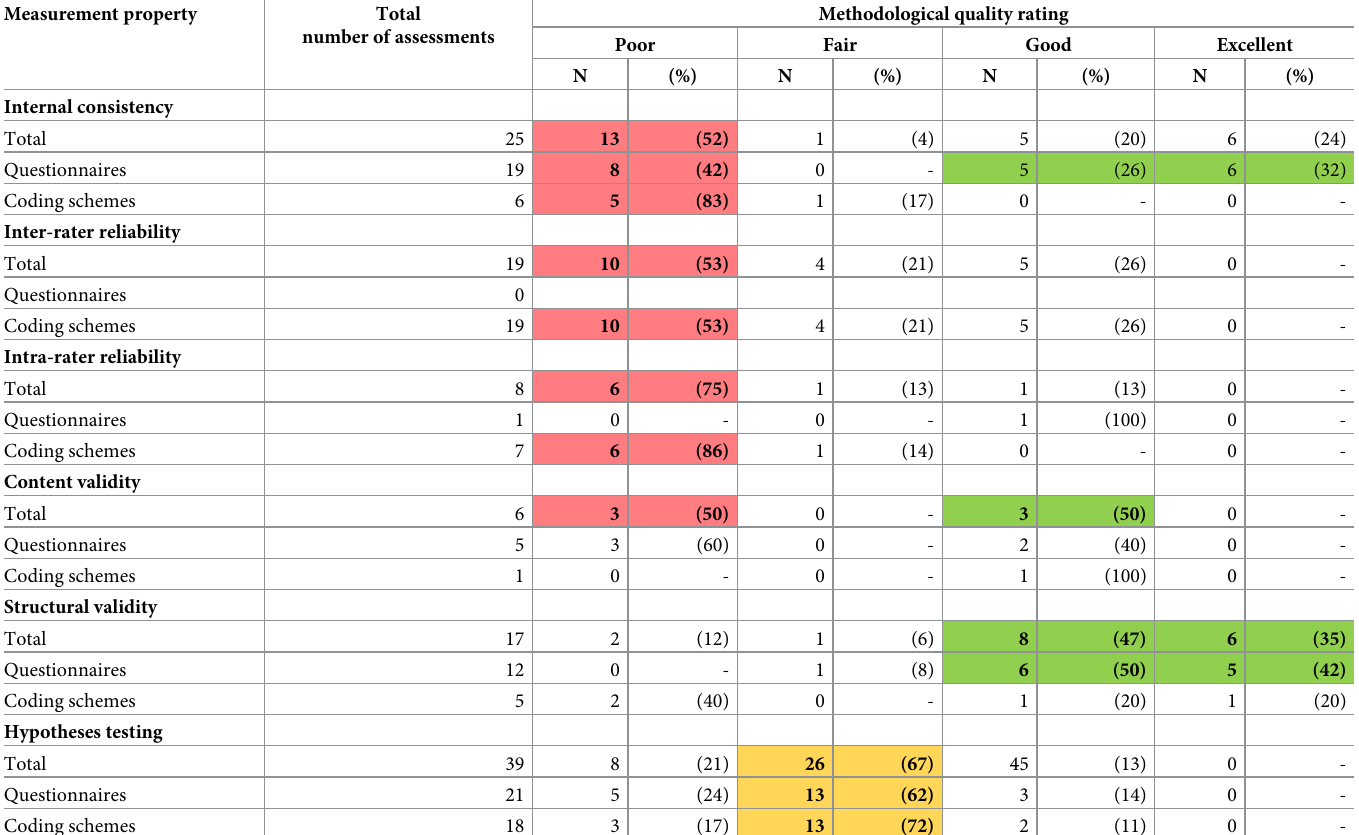
Table 8. Overall results on methodological quality of the studies that evaluated measurement properties of instruments measuring the process of SDM, as based on COSMIN checklist